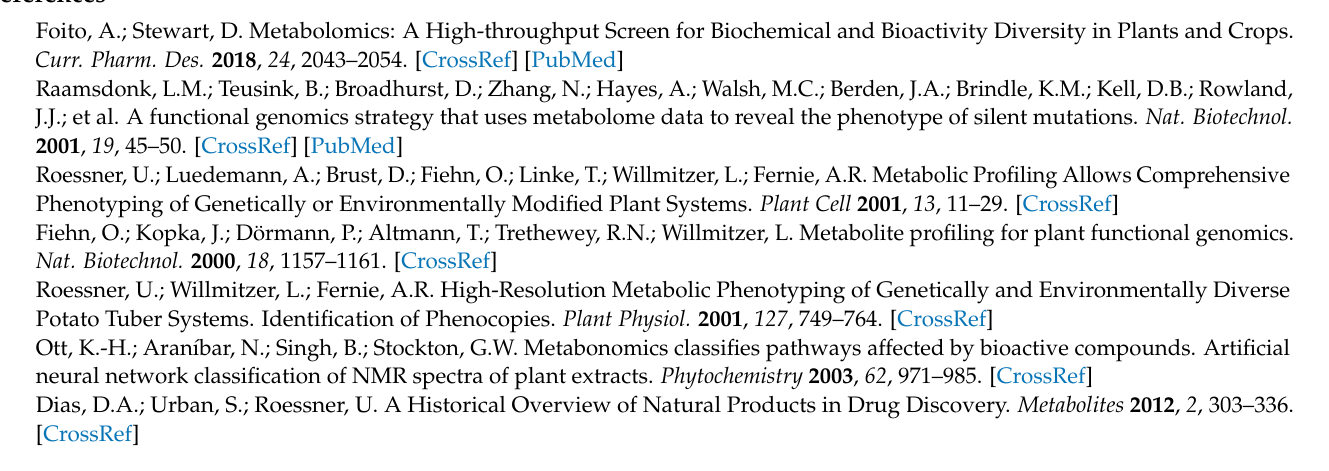
Table S2: Optimized MRM Transitions and Mass Spectrometer Parameters, Table S3: Calibration Regression, LOD and LOQ, Table S4: Intra- and Inter-day Accuracy and Precision, Table S5: Recovery Performance in Spiked NIST®SRM®1575a Pine Needle Extracts, Table S6: Validation Performance of Analytes Analyzed via DFI-MS/MS, Table S7: Detected and Quantified Plant Metabolite Concentra- tions in Different Samples. Supplementary Document S1: Detailed chemical vendor